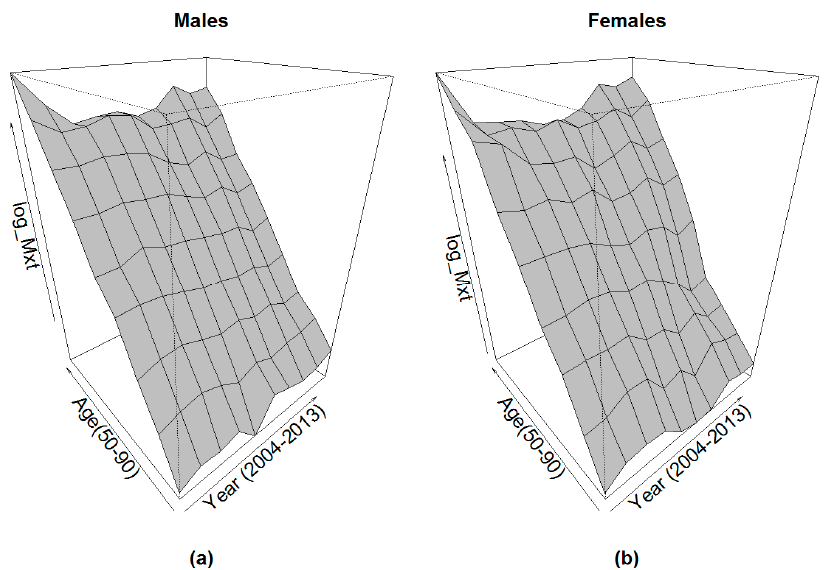
Figure 2. Crude mortality surfaces ( M t ): the five ages’ death rates in logarithm for males ( a ); x , x + 5 Figure 2 . Crude mortality surfaces ( 𝑀 𝑥,𝑥+5𝑡 ): the five ages’ death rates in logarithm for males ( a ); and and the five ages’ death rates in logarithm for females ( b the five ages’ death rates in logarithm for females ( b ).